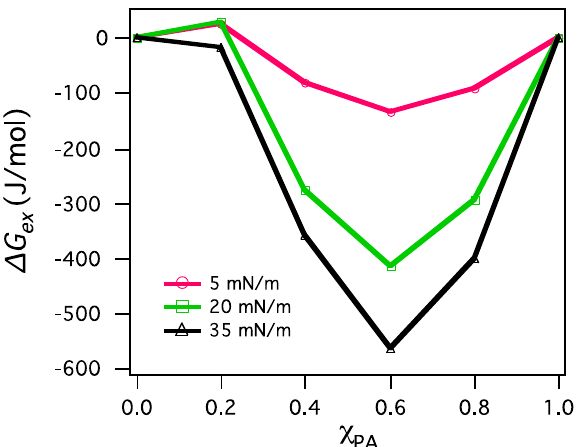
Figure 7. Excess free energies of mixing of PA/cerebrosides mixtures as a function of PA chemical composition at various surface